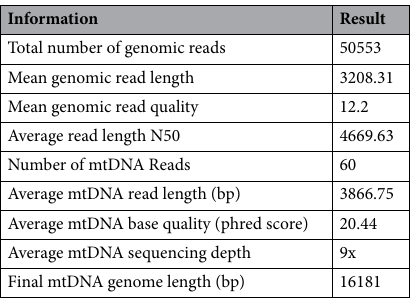
Table 1. Metrics for BJT022 minION mitogenome